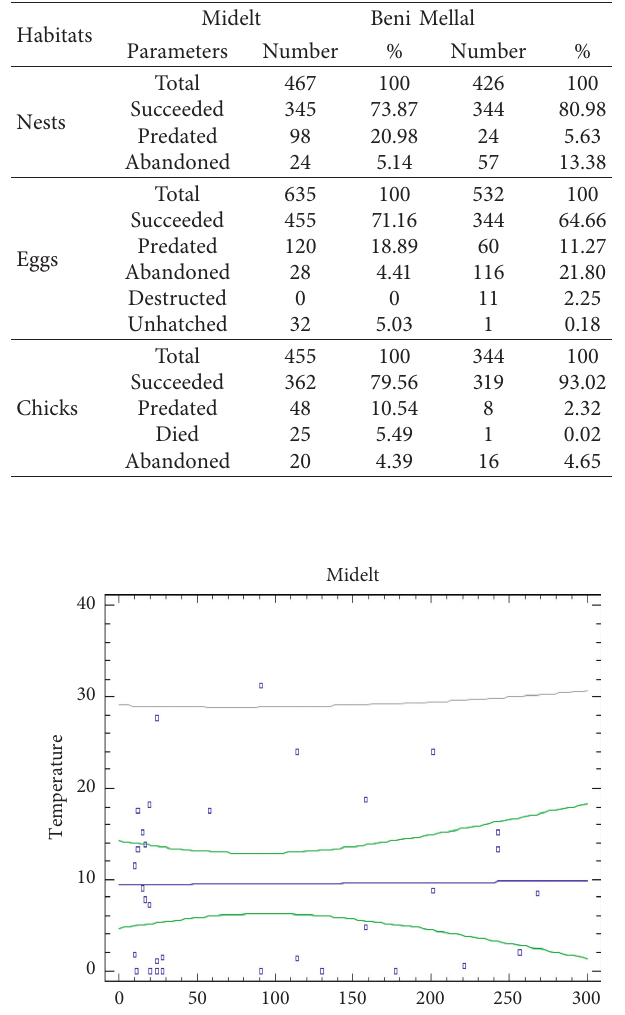
Table 3: Turtle dove’s breeding success at Midelt ( n � 20 apple orchards) and Beni Mellal ( n � 20 orange